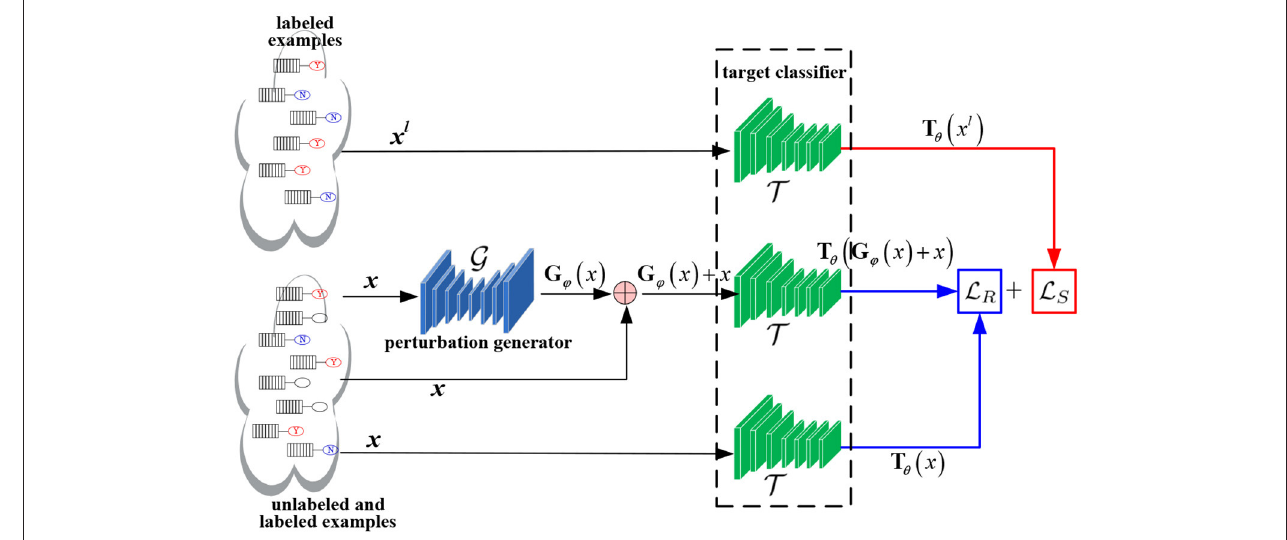
FIGURE 1 | The overall framework of Generative AT (GAT).